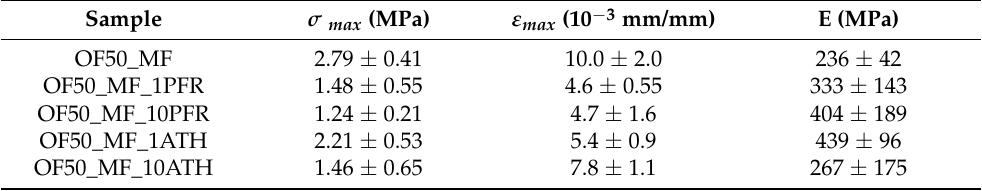
Figure 2. Stress/strain curves of the control and modified panels. The values of ultimate strength ( σ max ), strain at break ( ε max ), and modulus ( E ) for each sample type are reported in Table 2. Table 2. Values of ultimate strength ( σ max ), strain at break ( ε max ), and modulus (E) measured by flexural tests. Uncertainties are reported for all data as one standard deviation calculated over six independent